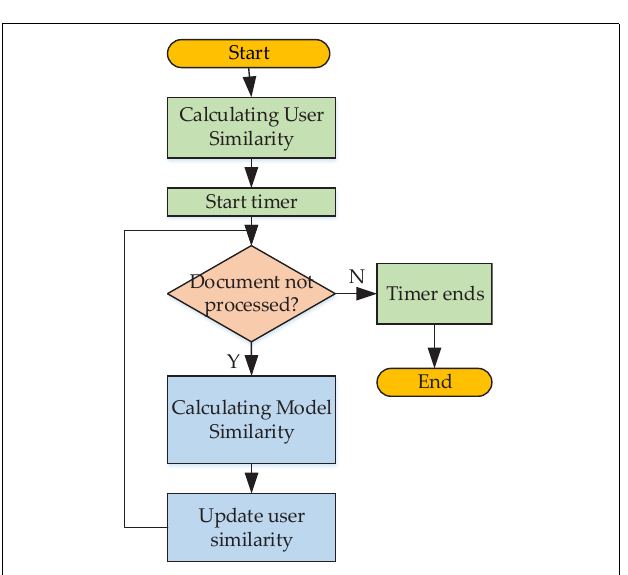
FIGURE 6 | Working flowchart of the user similarity calculation module.